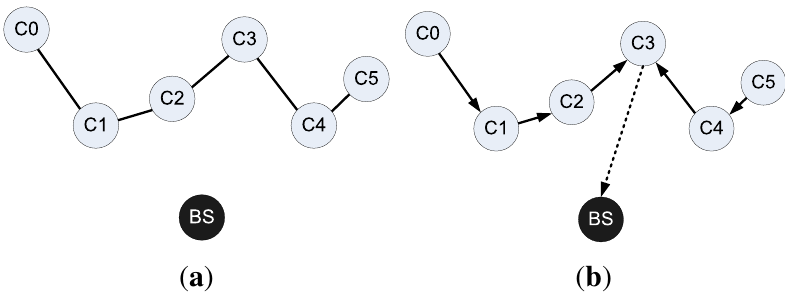
Figure 2. PEGASIS protocol chain. ( a ) chain formation using greedy method; ( b ) Data fusion at the leader node, and transmitting it to